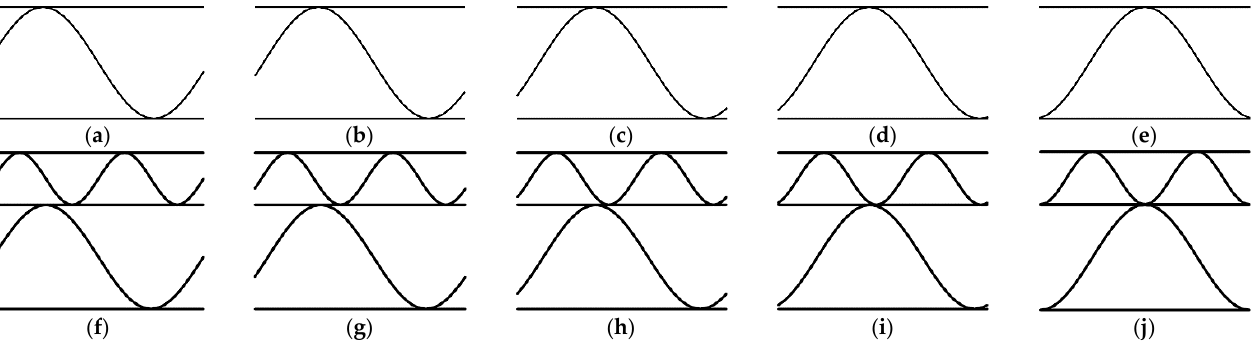
Figure 9. Cross section of the corrugated board along the wave: ( a ) the reference SW sample—no offset; ( b ) SW sample— offset equal to 1/16 P; ( c ) SW sample—offset equal to 2/16 P; ( d ) SW sample—offset equal to 3/16 P; ( e ) SW sample—offset equal to 4/16 P; ( f ) the reference DW sample—no offset; ( g ) DW sample—offset equal to 1/16 P; ( h ) DW sample—offset equal to 2/16 P; ( i ) DW sample—offset equal to 3/16 P; ( j ) DW sample—offset equal to 4/16 P.